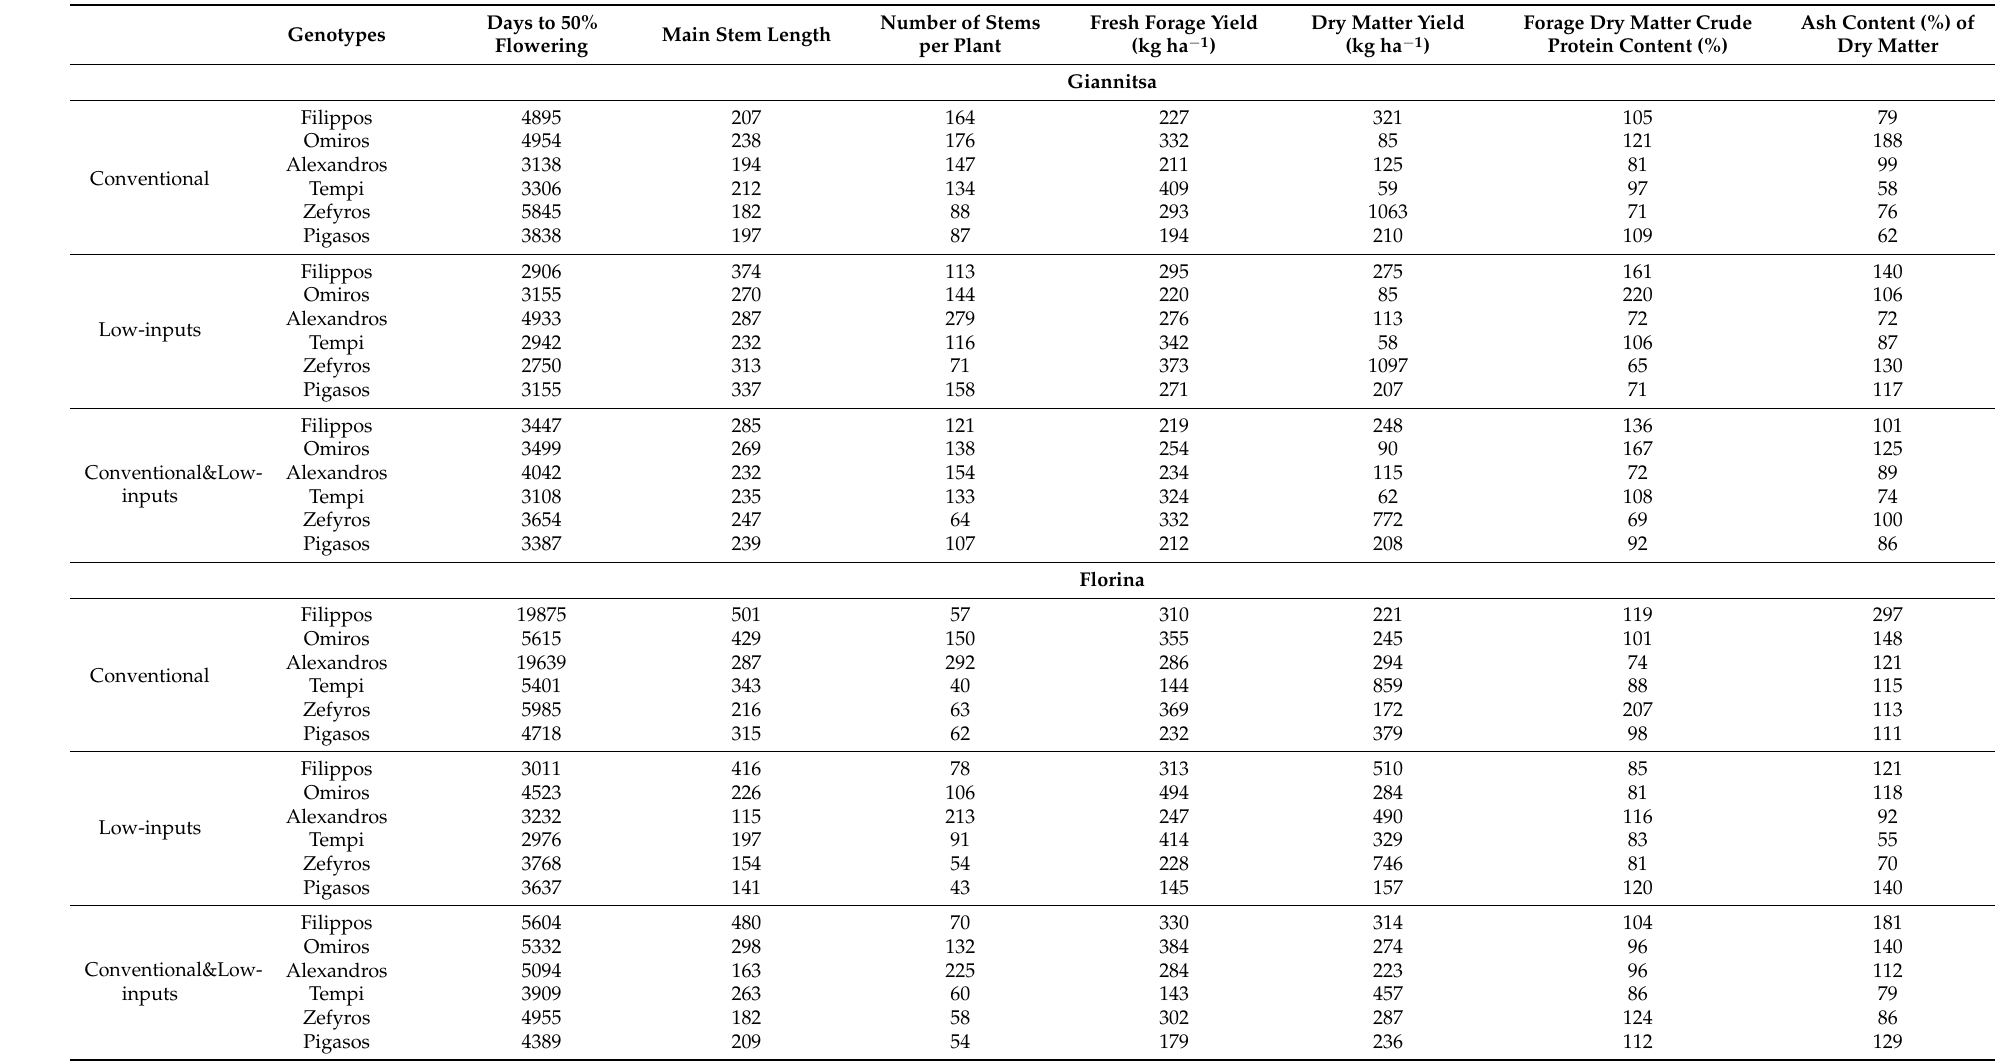
Table 4. Combined trait stability index across genotypes and environments, for the two farming systems: days to 50% flowering, main stem length, number of main stems per plant,